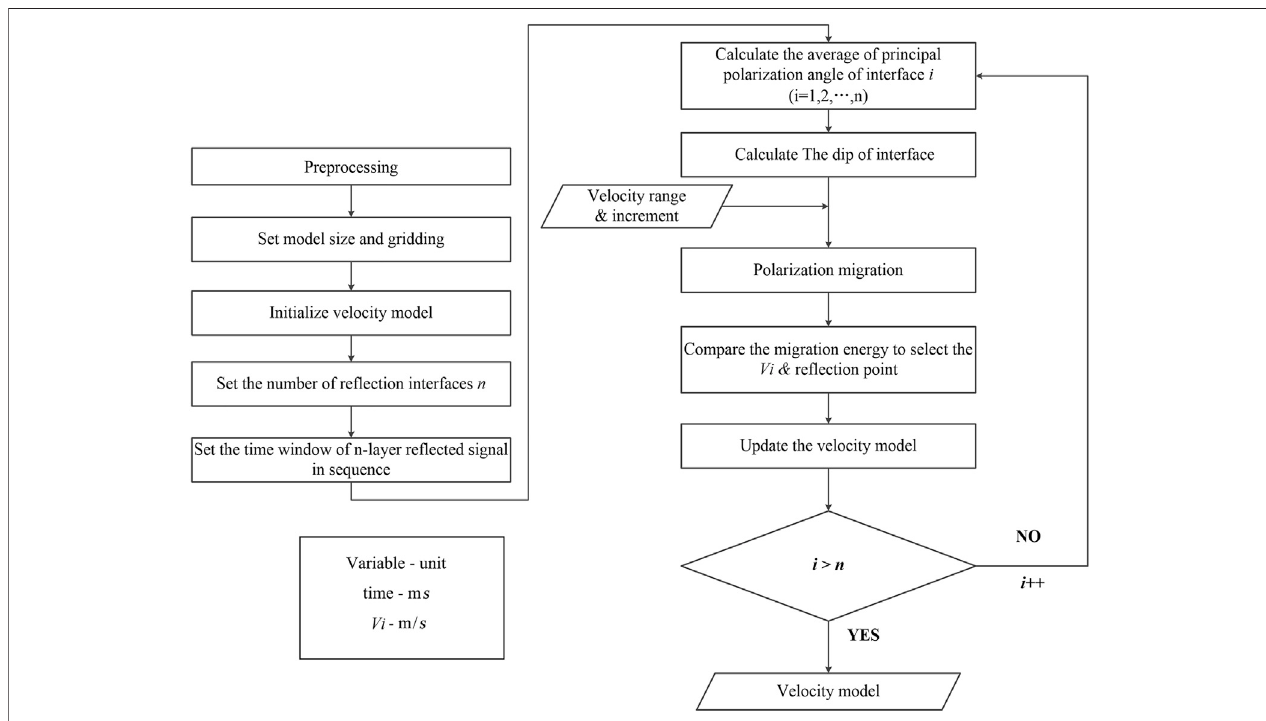
FIGURE 3 | Calculation fl owchart of the polarization migration velocity model building method for geological prediction ahead of the tunnel face.